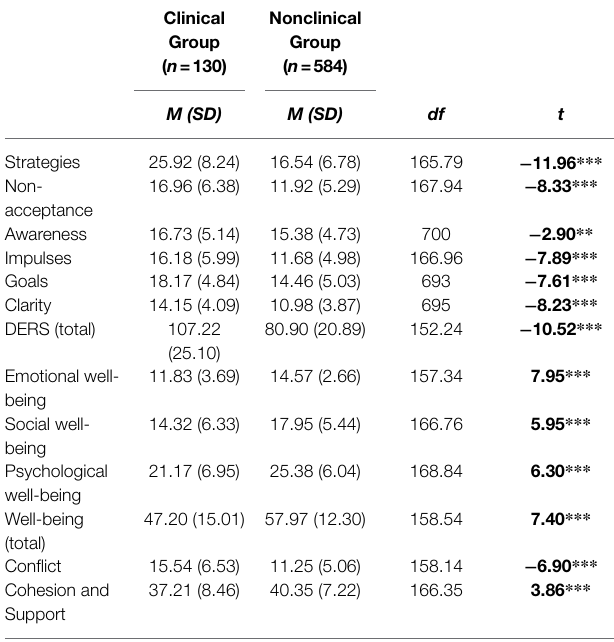
TABLE 3 | Comparison between clinical and nonclinical groups regarding emotional regulation difficulties, well-being, conflict, cohesion and support ( n =